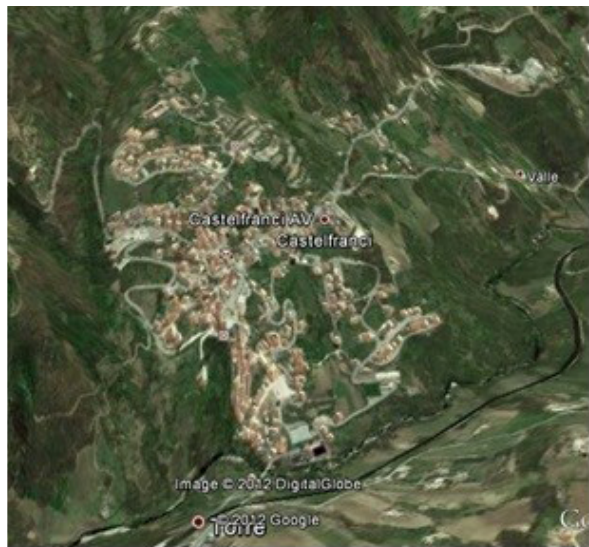
Fig. 1c. Google map 3-D view of Castelfranci (look to the east).